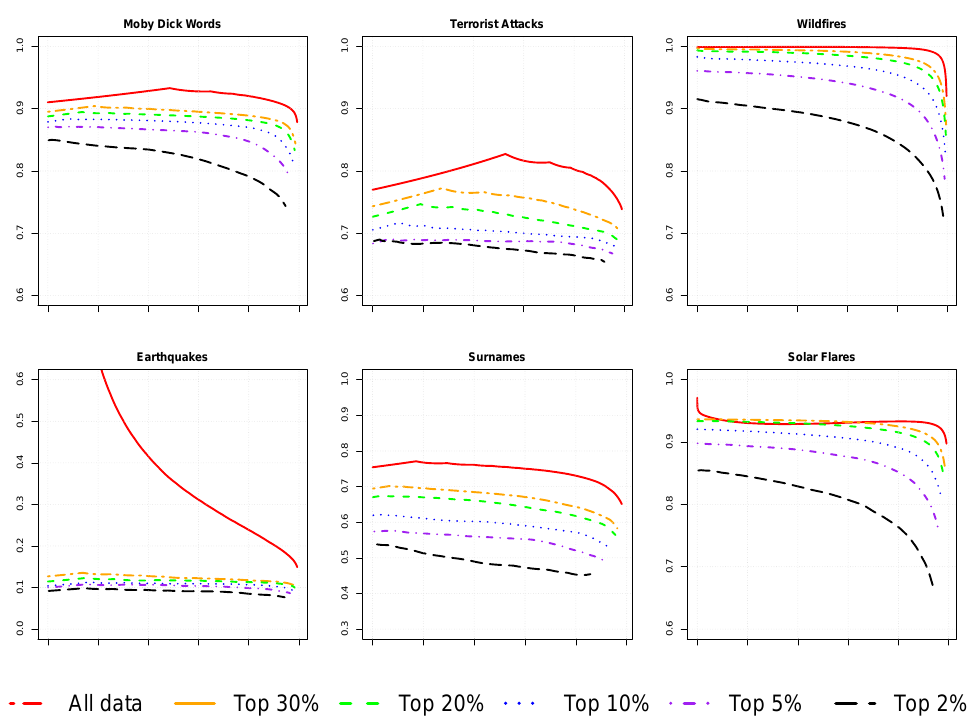
Figure 3. Plot of the estimated λ curves for the six dataset: all data and selected percentages of upper order statistics.